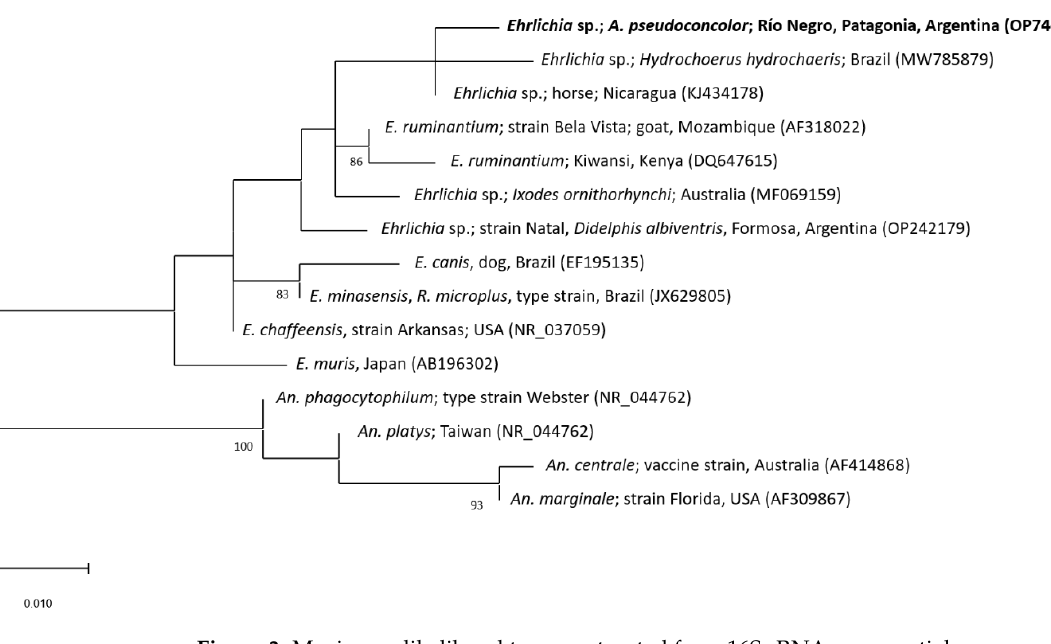
Figure 3. Maximum-likelihood tree constructed from 16S rRNA gene partial sequences of different Ehrlichia species (Substitution model: Hasegawa – Kishino – Yano model with Gamma distribution). Sequences of Anaplasma spp. were used as outgroup. The sequence generated in this study is written in bold letters. Numbers represent bootstrap support generated from 1,000 replications. Bootstrap values minor to 80 are not shown. GenBank accession numbers are given in brackets. Abbreviations: